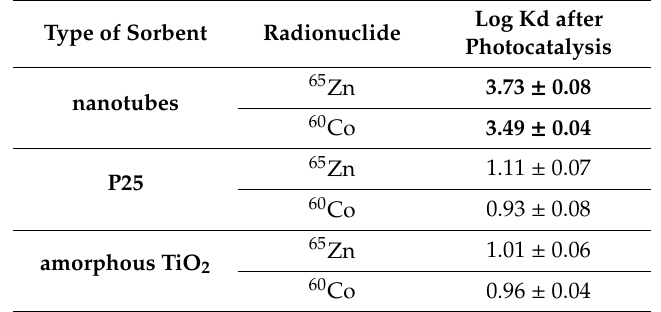
Table 2. Adsorption of 60 Co and 65 Zn on TiO 2 sorbents from simulated decontamination solutions (pH = 4) containing EDTA (5 × 10 − 4 M), oxalic acid (10 − 3 M), and citric acid (10 − 3 M), after photocatalytic decomposition of the